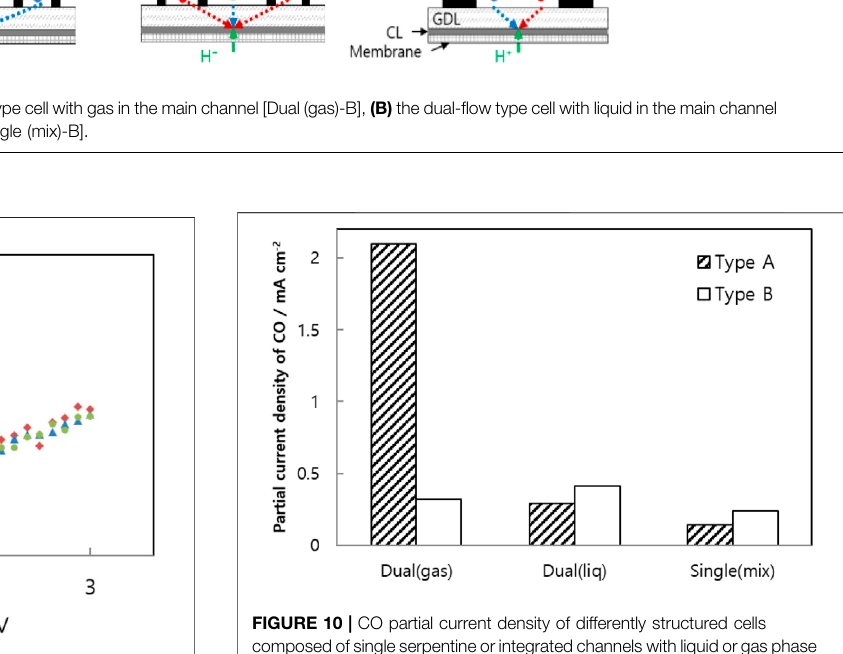
Figure 5B . The reference fl ow path is a serpentine channel on